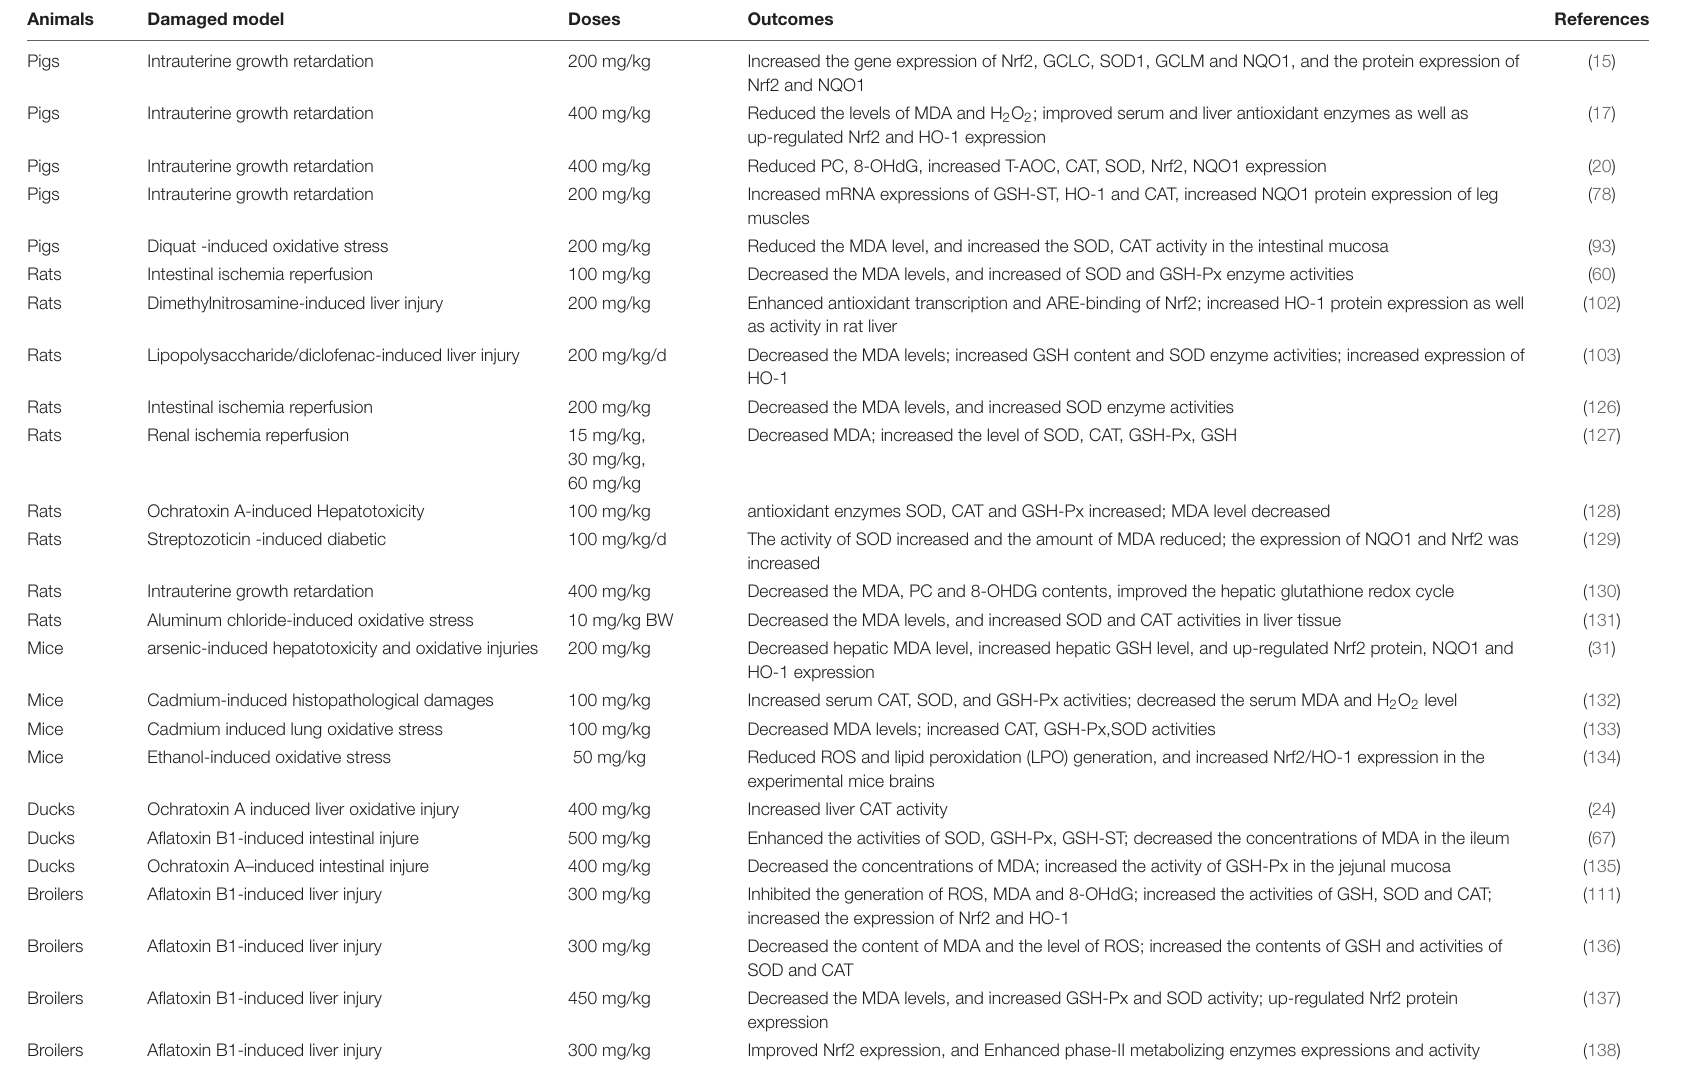
TABLE 2 | Summary of the in vivo studies investigating the antioxidant effect of curcumin. Animals Damaged model Doses